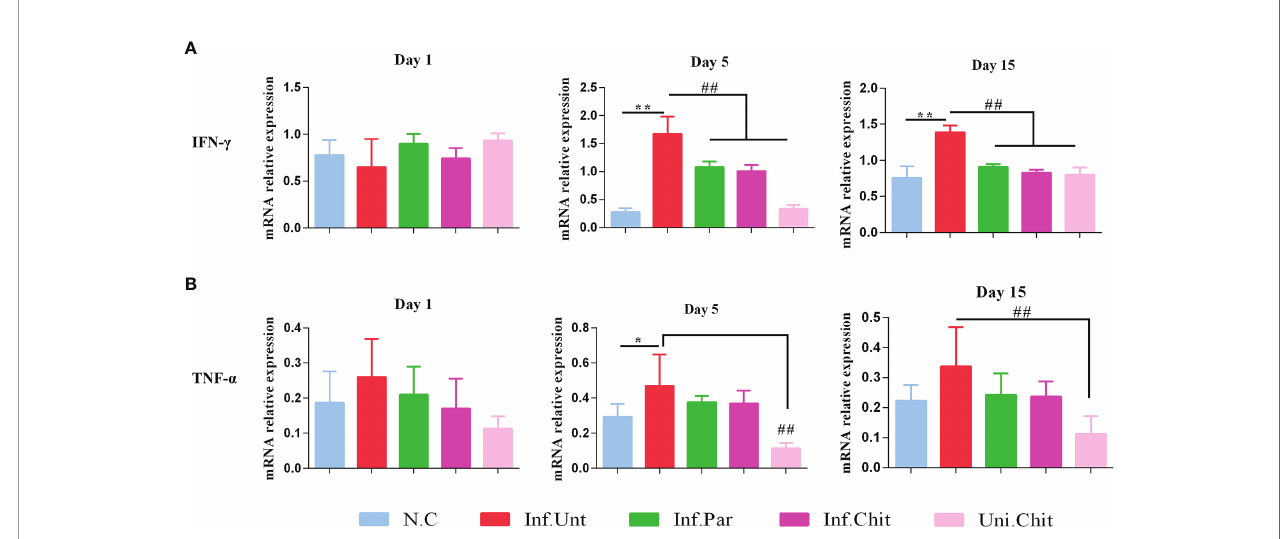
FIGURE 2 | Chitosan supplementation regulated the expression level of in fl ammatory cytokines (A) IFN- g and (B) TNF- a in C57BL/6 mice challenged with C. parvum . The above data presented as means ± SD of three independent tests. Signi fi cant differences among N.C vs. Inf.Unt groups are indicated by *p < 0.05, **p < 0.01. Signi fi cant differences between Inf.Unt vs. Inf.Par, Inf.Chit, and Uni.Chit are indicated by ## p < 0.01.